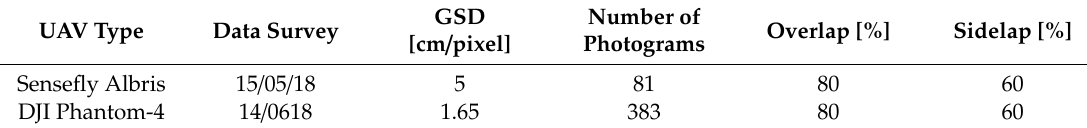
Table 2. Unmanned aerial vehicle (UAV) survey specifications.